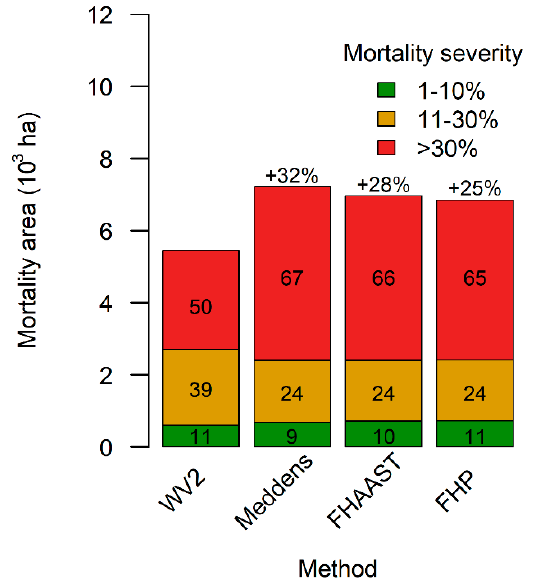
Figure 4. Total tree mortality area by mortality severity class and insect and disease survey (IDS) method, compared with WorldView-2 (WV2) damage within IDS polygons. The tree mortality maps derived from the WV2 scenes were aggregated to 90-m spatial resolution (0.81-ha grid cells), the median area of IDS polygons, to categorize WV2 mortality by mortality class. Percentages of each mortality severity class are given inside bars. Percentages by which IDS data overestimated mortality relative to WV2 are shown above bars.